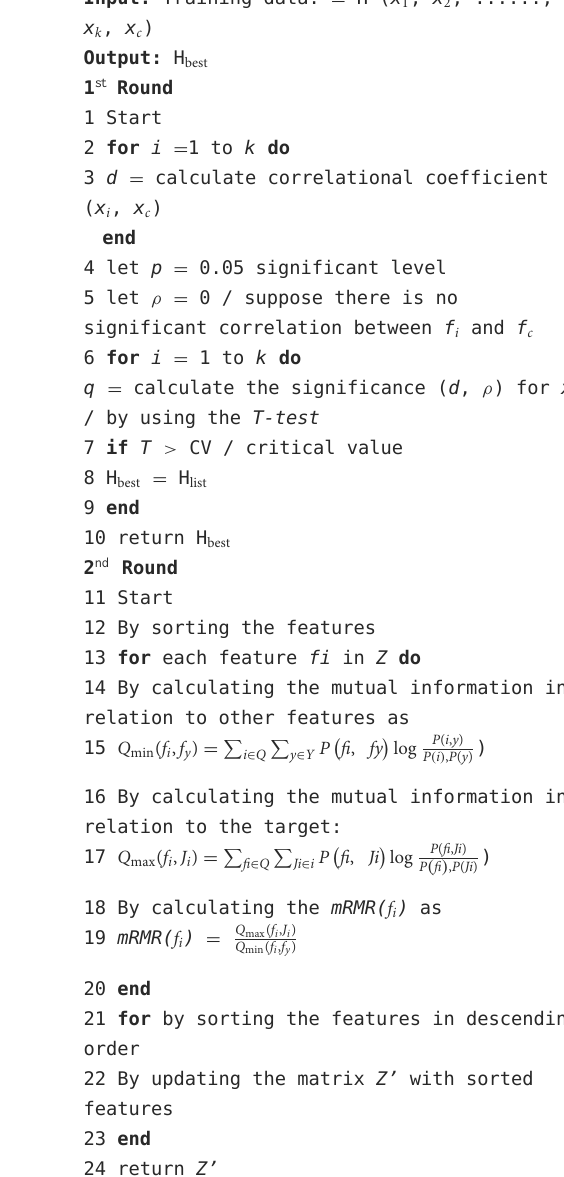
Algorithm 1. Correlation and mRMR-based Feature Selection